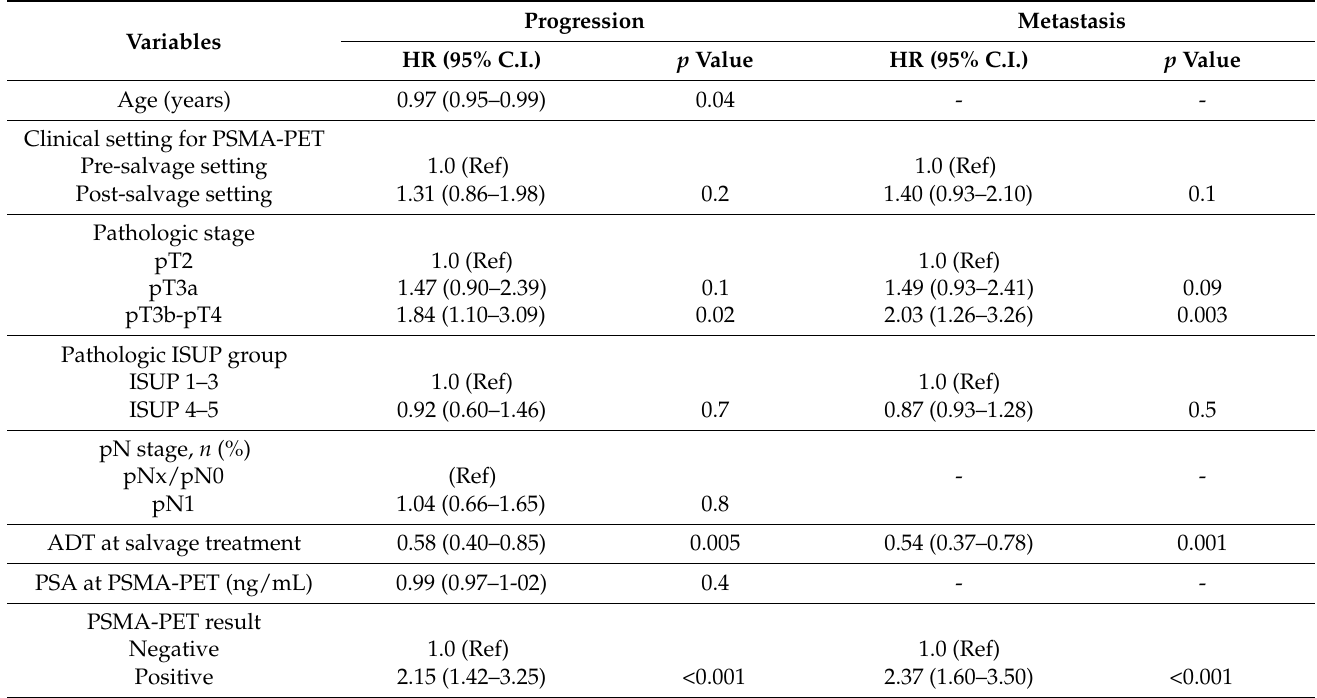
Table 3. Multivariate Cox regression to predict Progression free survival and Metastasis free survival in the overall population ( n =